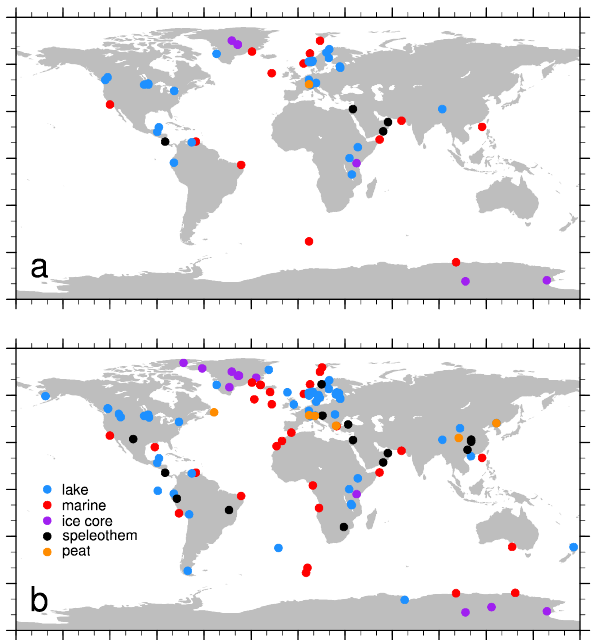
Fig. 1. Location of high-resolution proxy records spanning 8.2ka Figure 1. Location of high-resolution proxy records spanning 8.2 ka that were available in (a) 2 that were available in (a) 2005 (Morrill and Jacobsen, 2005) and 2005 (Morrill and Jacobsen, 2005) and (b) 2012. 3 (b) 2012.